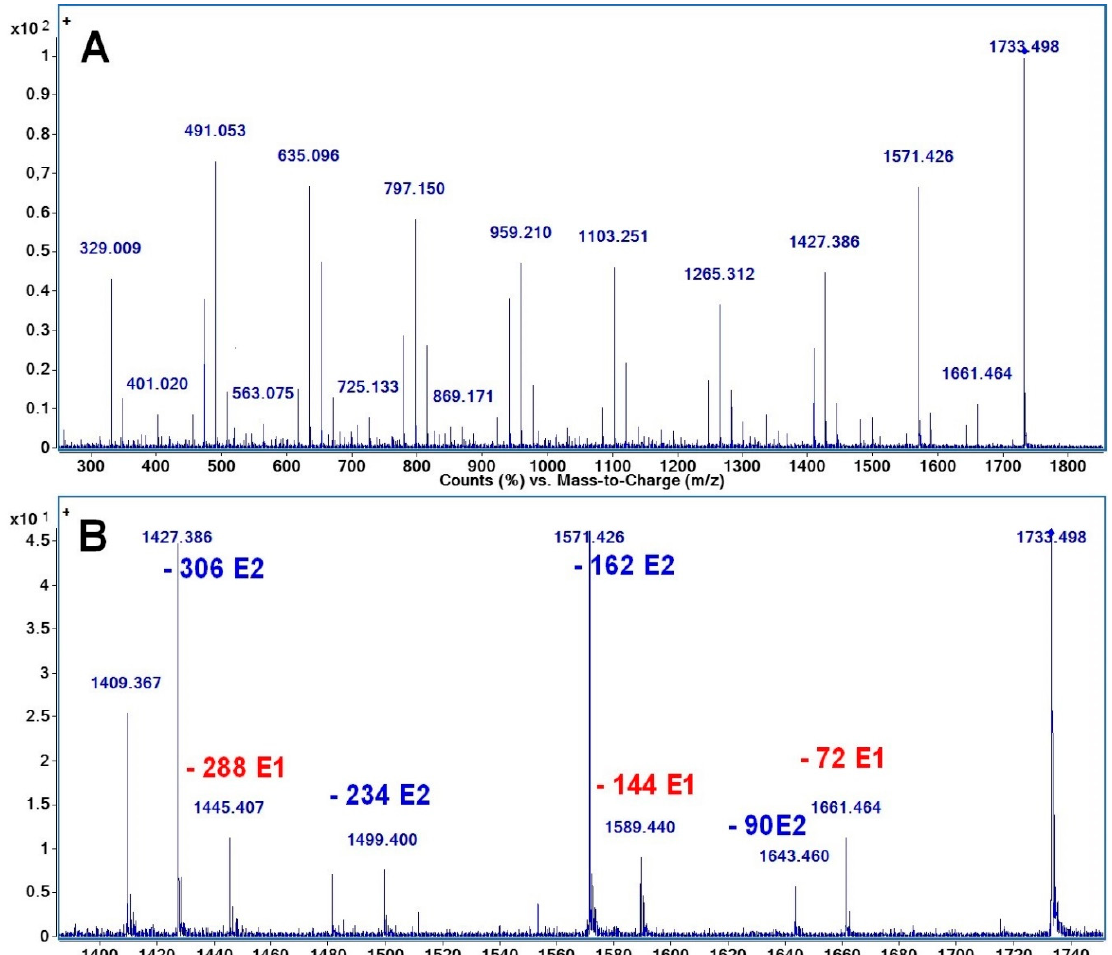
Figure 2. CID-MS/MS spectrum of [CD-LA 4 + Na] + precursor ions: ( A )—full spectrum, ( B )—enlarged region between m / z —1400–1740. Table 1. The m / z values of the fragments issued from the semiacetalic bond cleavages; the values corresponding to the most intensive peaks are highlighted and the values of the peaks which were not found or were of low intensity are not